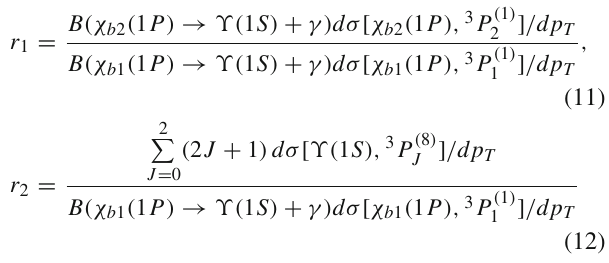
dictions obtained with the KMR gluon density. Shaded bands represent the NME uncertainties of our calculations, as it is described in the text. The experimental data are from ATLAS